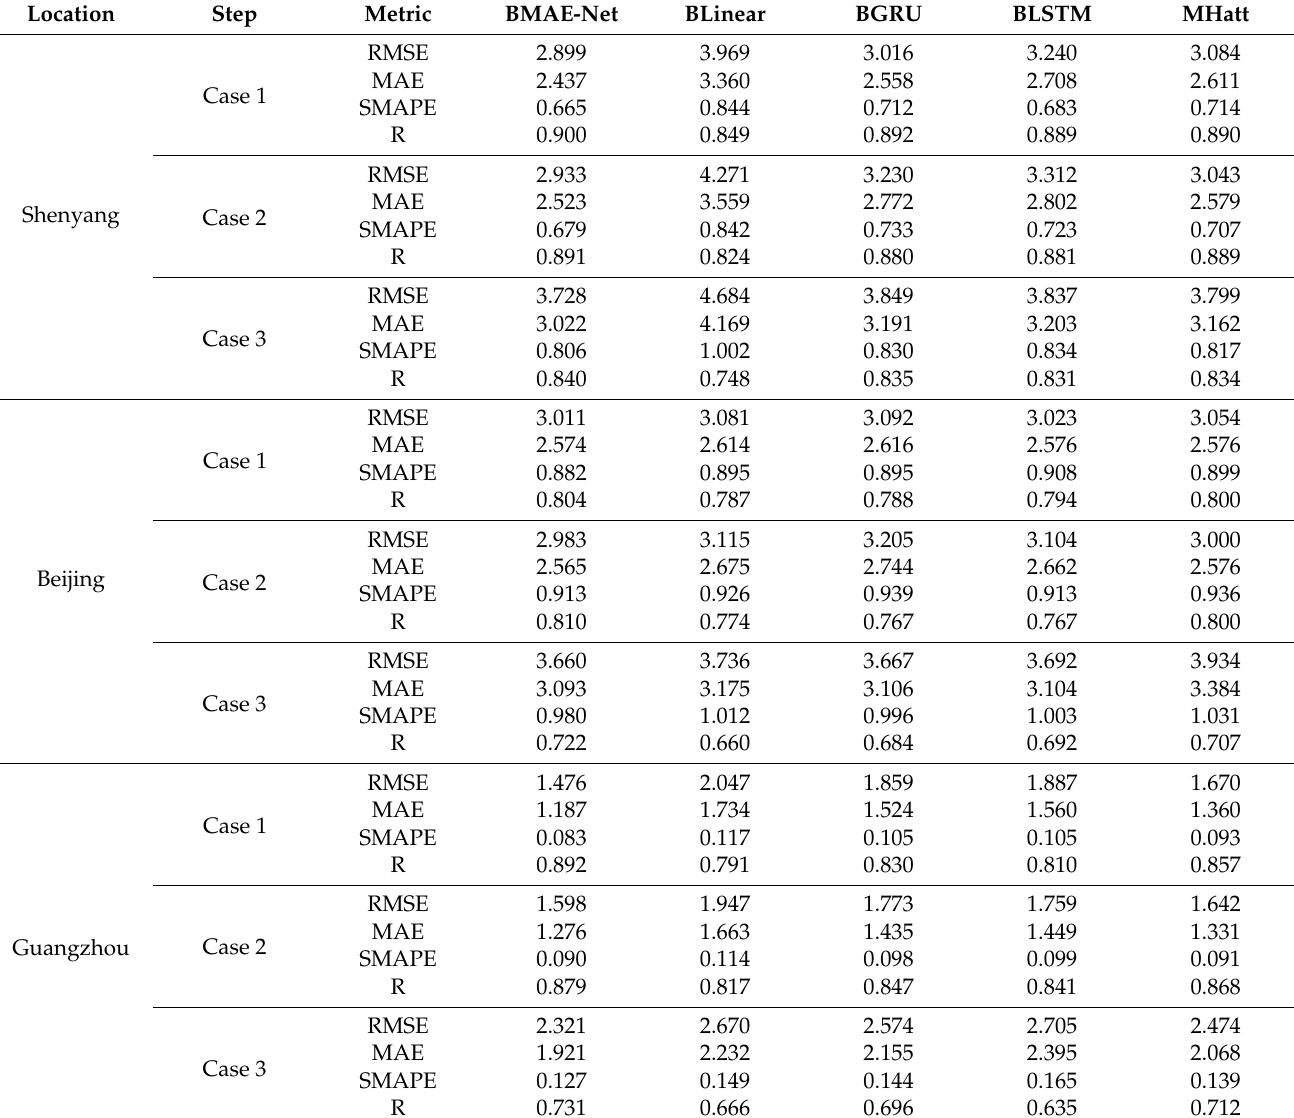
Table 6. The experimental results for temperature for each